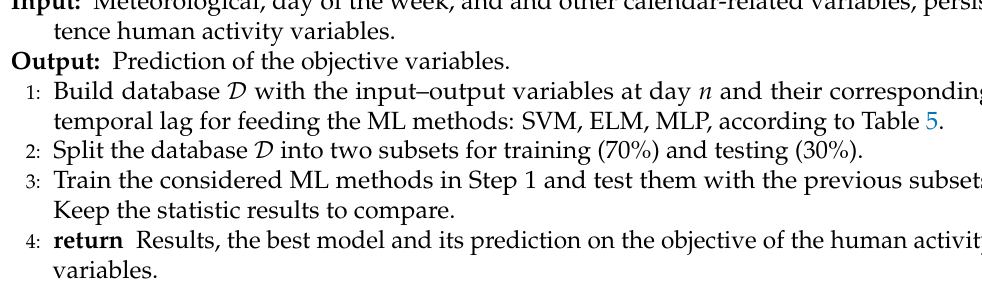
Algorithm 1 Pseudo-code of ML methods for prediction problems with human activity